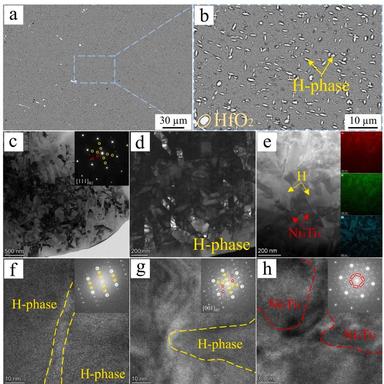
Microscopic morphology of Ni55Ti37Hf8 alloy after heat treatment at 600 ℃ for 100 h, (a)-(b) SEM morphology, (c)-(d) Low-magnification TEM morphology, (e) HADDF morphology with corresponding elemental mapping of Ni (red), Ti (green), and Hf (blue), (f)-(h) High-resolution morphology of alloy.